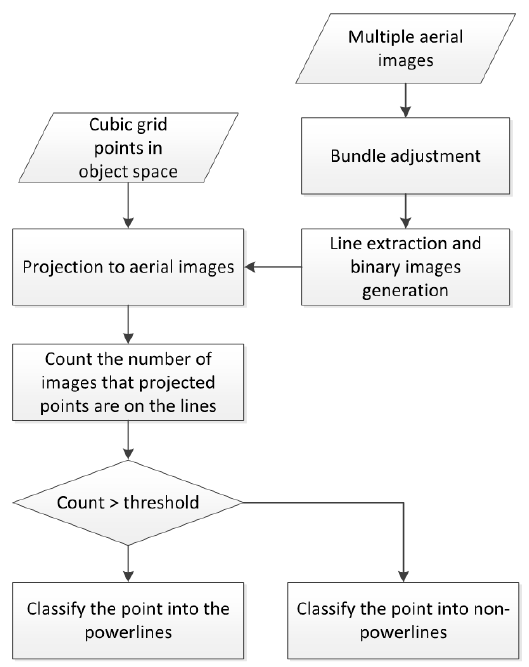
Figure 1. Flowchart of the power line extraction.